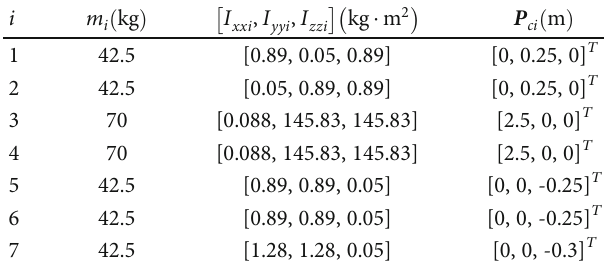
Table 7: The dynamic parameters of the 7-DOF space